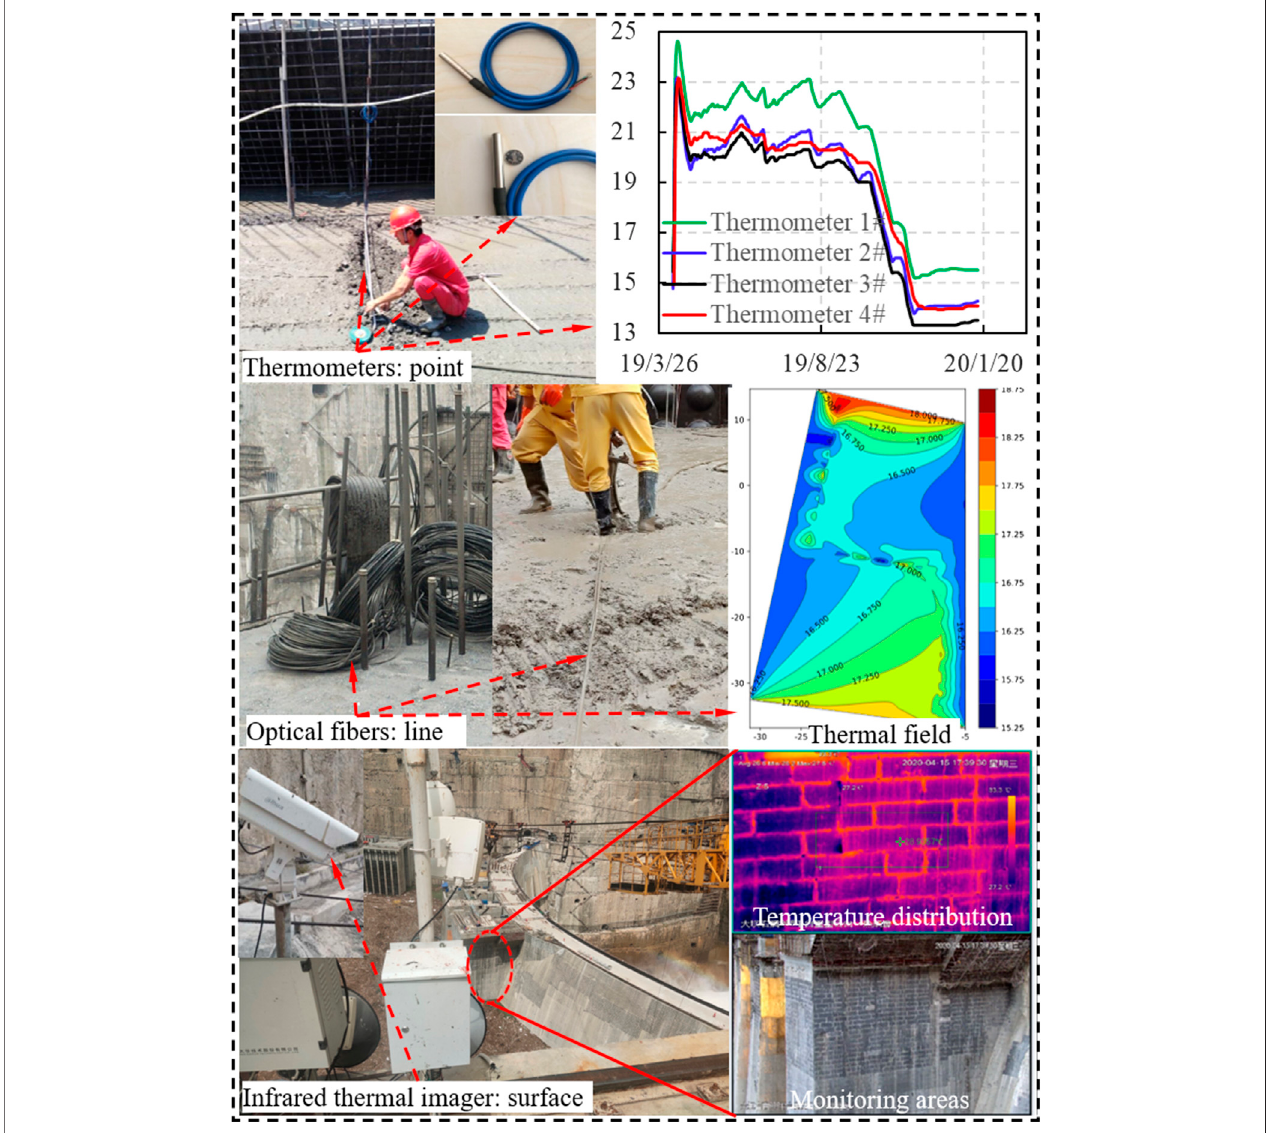
FIGURE 10 | Layout of thermometers, distributed optical fi bers and infrared thermal imagers in the super-high arch dam.